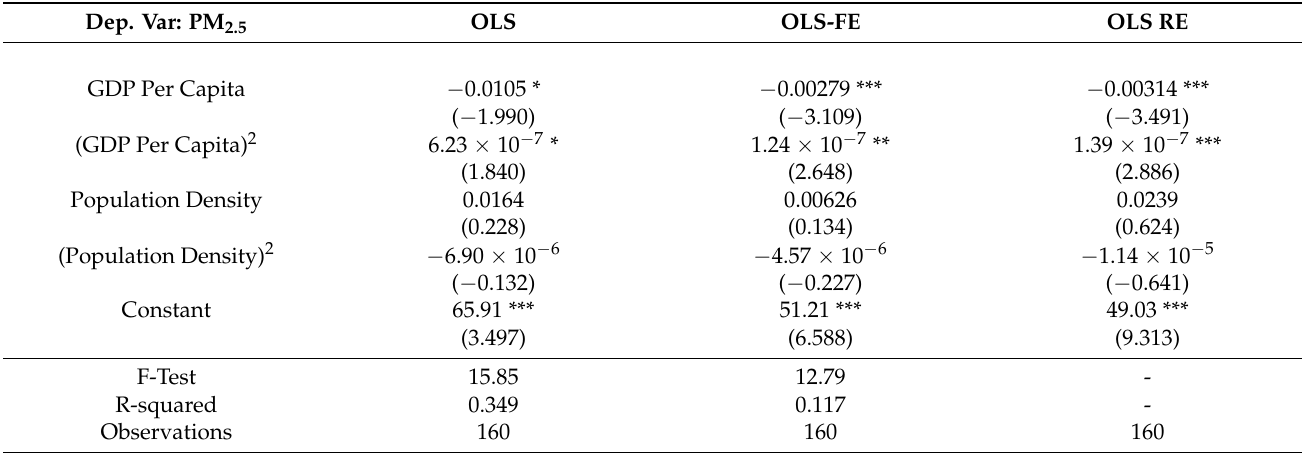
Table 2. First-stage estimation for air pollution (PM 2.5